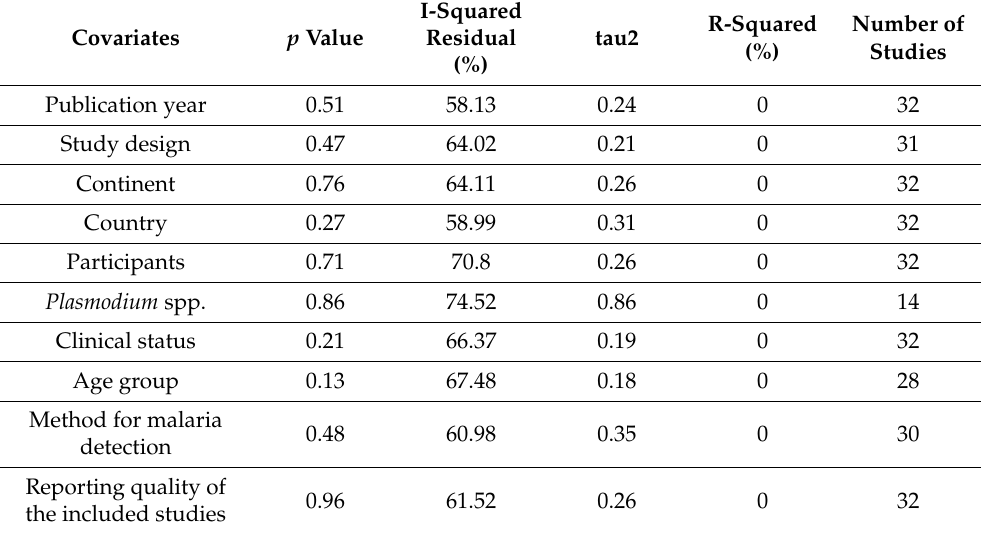
Table 2. Metaregression